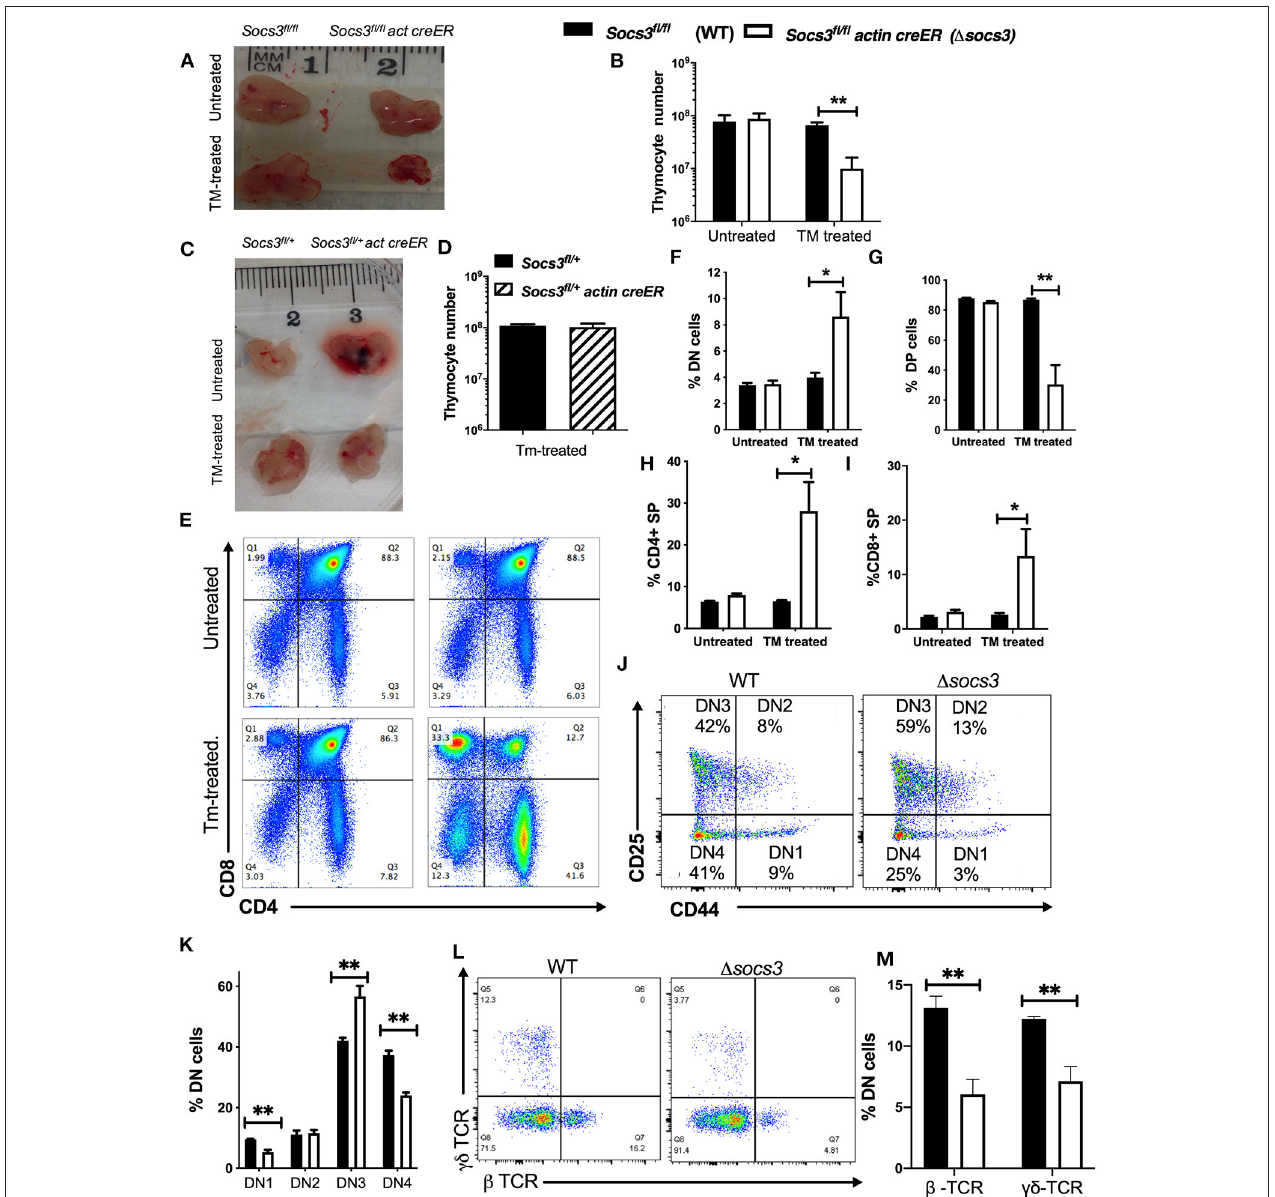
FIGURE 1 | SOCS3 is required for maintenance of thymus structure and thymocyte differentiation. (A) Representative image and (B) mean total thymic cell numbers from 1 socs3 and WT mice untreated or 7 days after the last dose of Tm. (C) Photograph from Socs3 fl / + and Socs3 fl / + actin creER thymi 7 days after Tm or left untreated. (D) Mean thymocyte numbers ± SEM from Socs3 fl / + and Socs3 fl / + actin creER mice 10 days after Tm treatment. Differences between groups are significant at * p ≤ 0.05, ** p ≤ 0.01 ANOVA with Welch correction. (E) Representative dot plots and mean frequencies of lineage negative (F) DN, (G) DP, (H) CD4, and (I) CD8 SP thymocytes ± SEM in 1 socs3 and WT mice (6 per group) treated or not with Tm. Four independent experiments were performed. These experiments were repeated more than 5 times with similar results. Differences between groups are significant at * p ≤ 0.05, ** p ≤ 0.01 ANOVA with Welch correction. (J) Representative plot and (K) mean of frequency of DN1-DN4 1 socs3 and WT subpopulations ± SEM ( n = 5 per group) defined by CD44 and CD25 expression. Differences between groups are significant at ** p ≤ 0.01 unpaired Student’s t- test. (L) Representative dot plots and (M) mean frequency ± SEM (M) of γδ and β TCR + cells within the DN thymocyte population in 1 socs3 and WT mice ( n = 6 per group). Differences between groups are significant at ** p ≤ 0.01 unpaired Student’s t- test.